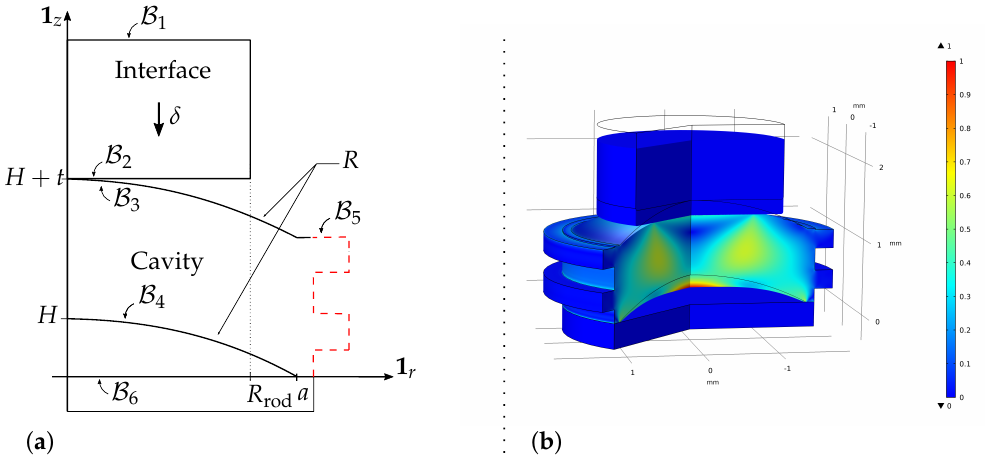
Figure A4. ( a ) Sketch of the domains and boundaries for the numerical model solving the compression of the cavity by the interface. The zero displacement on boundary B 5 is indicated by the dashed line. ( b ) Example of the axisymmetric model solved for δ = 0.2 mm: normalized stress σ / max ( σ ) . B B 6 . The clamping condition 4 is left free to deform until it contacts the boundary on B 6 and B 5 (the shape of which came from the molding of the membrane inside the = u | = 0 , where u = u + u gripper’s core), reads u | B r 1 r z 1 z is the displacement field B 6 5